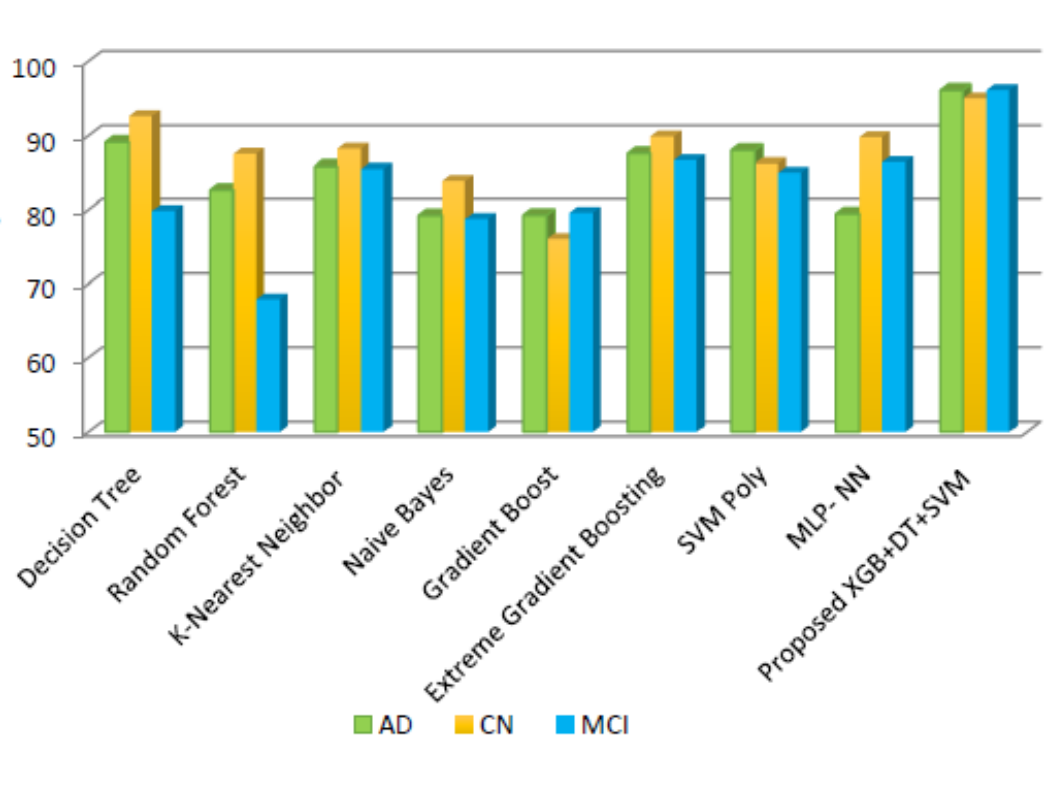
Figure 8b represents the performance of models after using GridSearch which includes the SVM polynomial kernel along with other models, whereas, in Figure 8a, all three SVM kernels are included along with other implemented models. Overall, it is demonstrated that model tuning enhances the performance and classification accuracy of all the models.